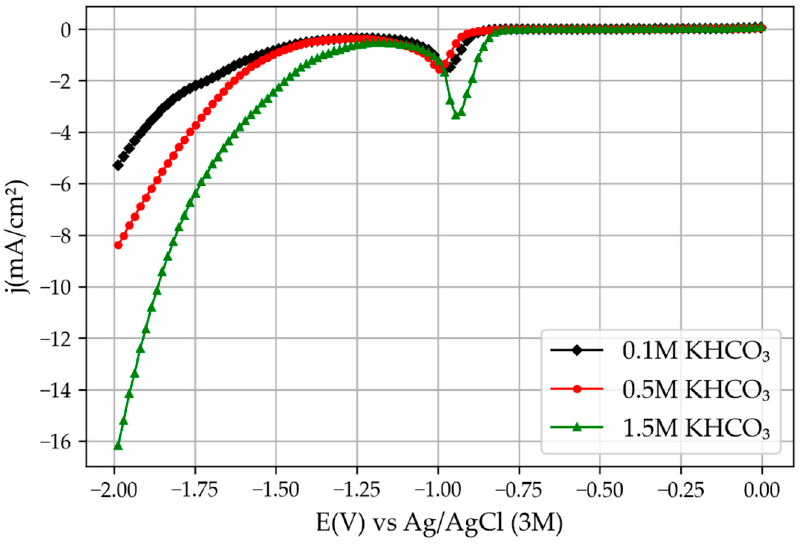
Figure 7. Linear voltammetry results obtained with the old CNC-manufactured module reprinted from [6].